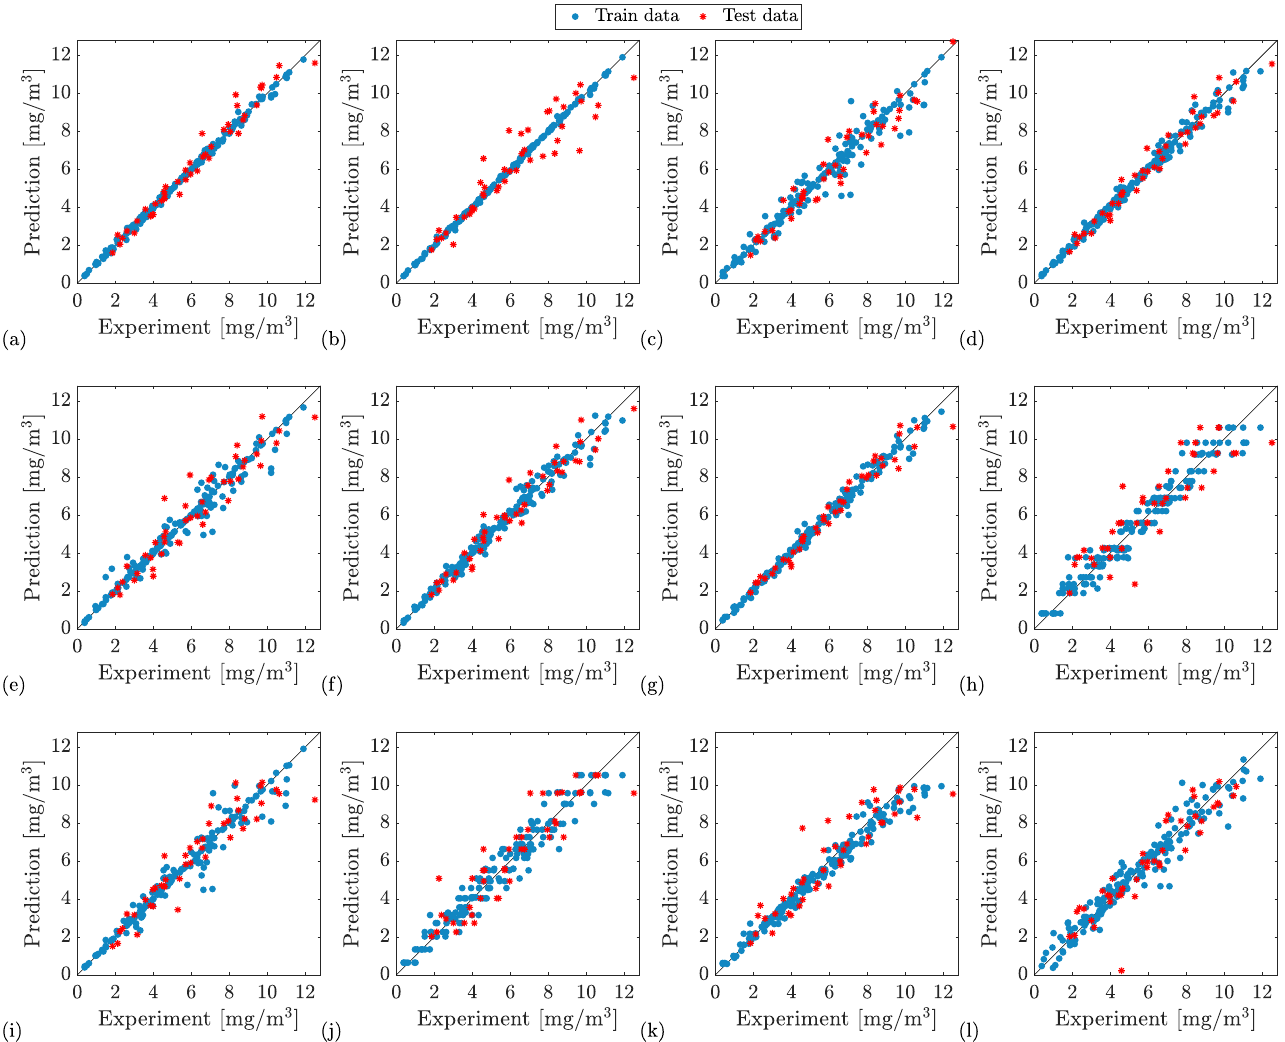
Figure 13. Comparison of model prediction against experimental data for different models including ( a ) GPR: GB + PHYS, ( b ) 1-HL BNN: GB + PHYS, ( c ) SVM: GB + PHYS + L, ( d ) GPR: GB + PHYS + L, ( e ) SVM: GB, ( f ) GPR: GB, ( g ) GPR: BB + L, ( h ) RT: GB + PHYS + L, ( i ) SVM: GB + PHYS, ( j ) RT: GB, ( k ) ERT: BB + L, ( l ) SVM: BB + L (good accuracy is when the data follows the diagonal